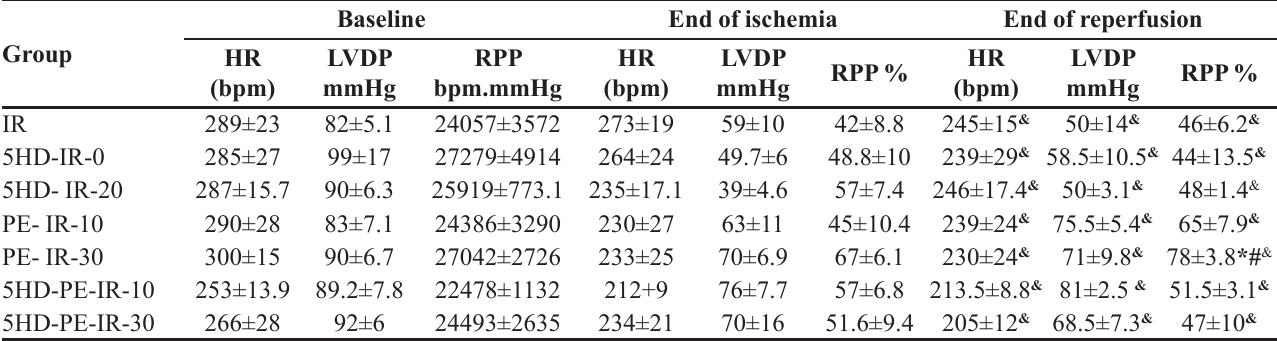
TABLE I - Hemodynamic parameters. HR (heart rate, beat per minute); LVDP (left ventricular developed pressure); RPP (rate pressure product) (beats/min mmHg × 10 3 ) in ischemia/reperfusion (IR), 5HD perfused at the onset of regional ischemia (5HD- IR-0), 5HD perfused 20 min after regional ischemia (5HD-IR-20), phenylephrine-early perconditioning 10 min after ischemia (PE-IR-10), phenylephrine-late perconditioning 30 min after ischemia (PE-IR-30), 5HD-phenylephrine-early perconditioning (5HD-PE-IR-10), 5HD-phenylephrine-late perconditioning